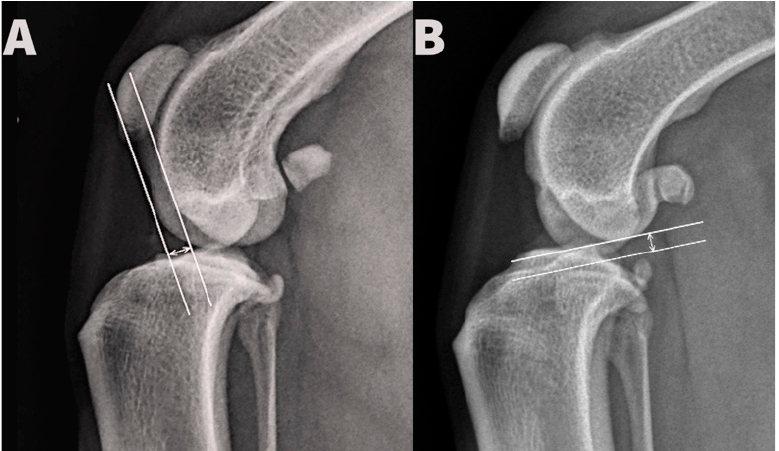
Figure 2. Measurement of the cranio-caudal ( A ) and proximo-distal ( B ) distance between the medial and lateral condyle.